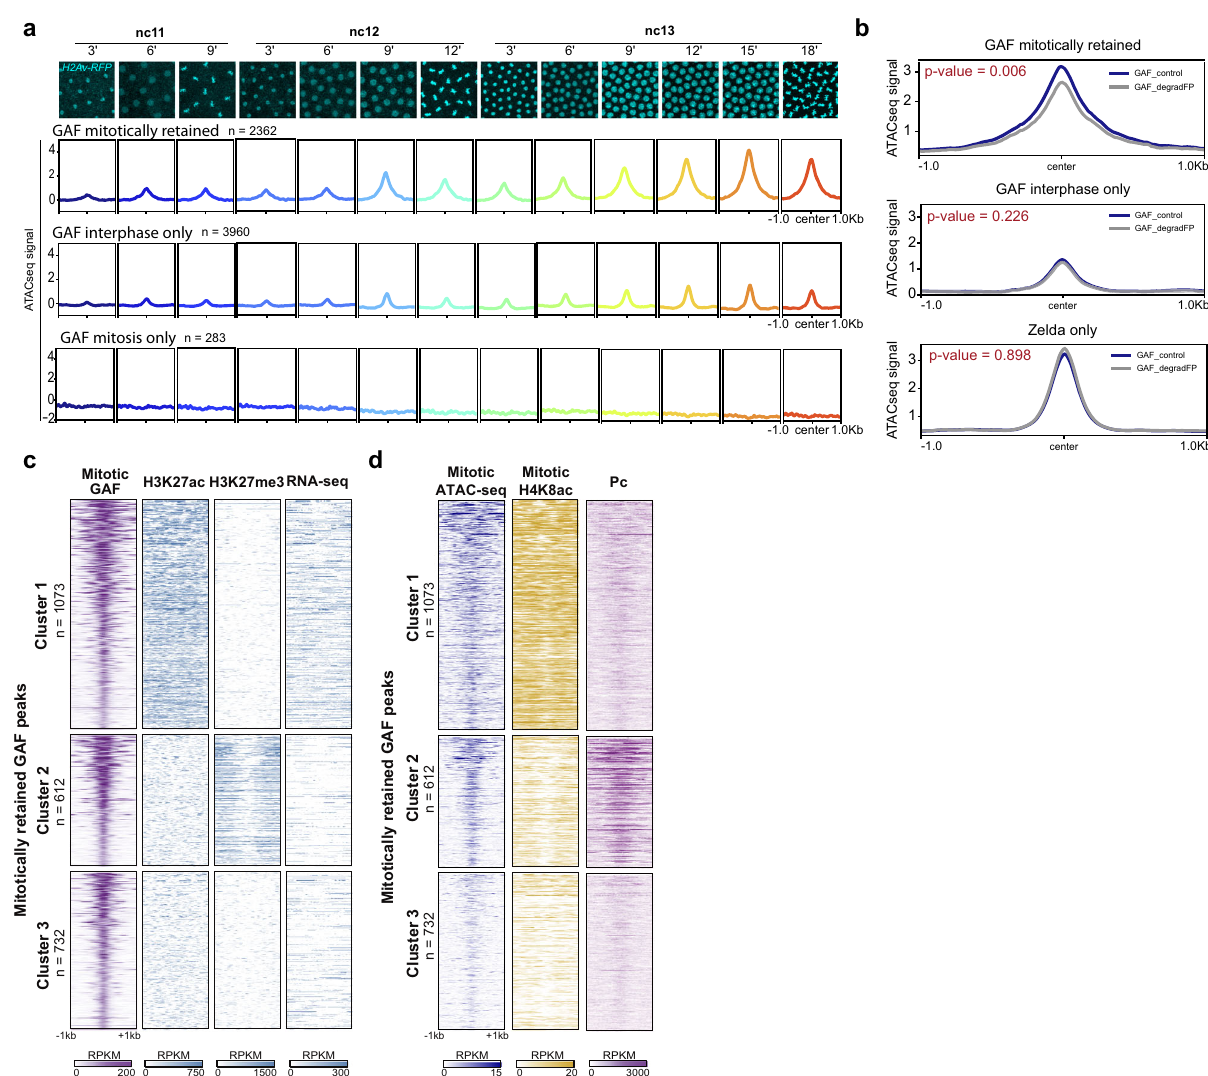
Fig. 3 Mitotically retained GAF loci become progressively accessible during Zygotic Genome Activation. a Metagene pro fi les of ATAC-seq signal 54 centered at mitotically retained interphase only and mitosis-only GAF-ChIP-seq peaks across the indicated stages and represented by the time-lapse images from a movie of His2Av-mRFP embryos (cyan). n : number of identi fi ed GAF peaks. b Metagene pro fi les of ATAC-seq signal in WT (GAF_control, dark blue) and GAF-depleted (GAF_degradFP, gray) embryos (2 – 2.5 h after egg laying) 28 on GAF mitotically retained, GAF interphase-only and Zelda-only regions. P values are from two-sided Wilcoxon rank-sum test with continuity correction, used to compare the curves of ATAC-seq accessibility in GAF_control and GAF_degradFP from − 500 bp to + 500 bp from the center of the peaks. c Heatmaps of k -means clustered mitotically retained GAF peaks, based on H3K27ac and H3K27me3 ChIP-seq 56 and RNA-seq 57 from n.c. 14 embryos. n : number of identi fi ed GAF peaks. d Heatmaps representing the mitotic ATAC-seq signal 54 (dark blue) from interphase n.c.13 embryos, the ChIP-seq enrichment of H4K8ac in mitotic embryos and the ChIP-seq enrichment of Polycomb (Pc) 51 at the clustered mitotically retained GAF peaks from ( c ). n : number of identi fi ed GAF